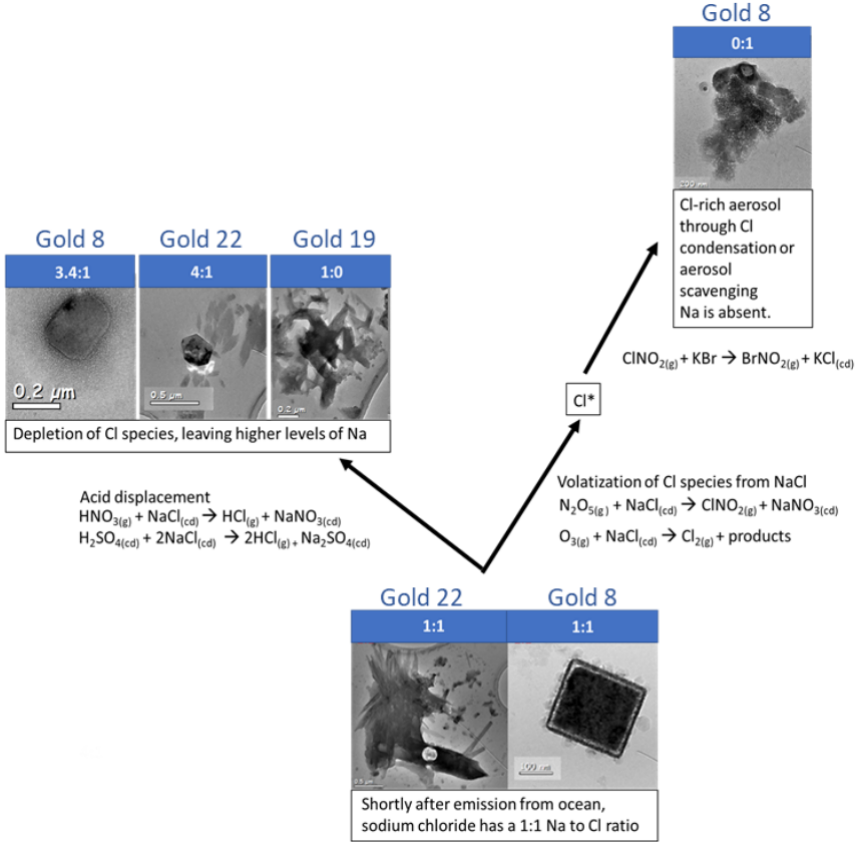
Figure 5. Schematic showing different stages of sea salt conversion with example mechanisms. The particles are from CLARIFY filters and range from sea salts which have been freshly emitted to Cl-depleted particles containing nitrates and sulfates. Cl aerosol formation is also shown. Na : Cl ratios showing depletion of Cl with sea salt conversion are shown in the bar above each particle